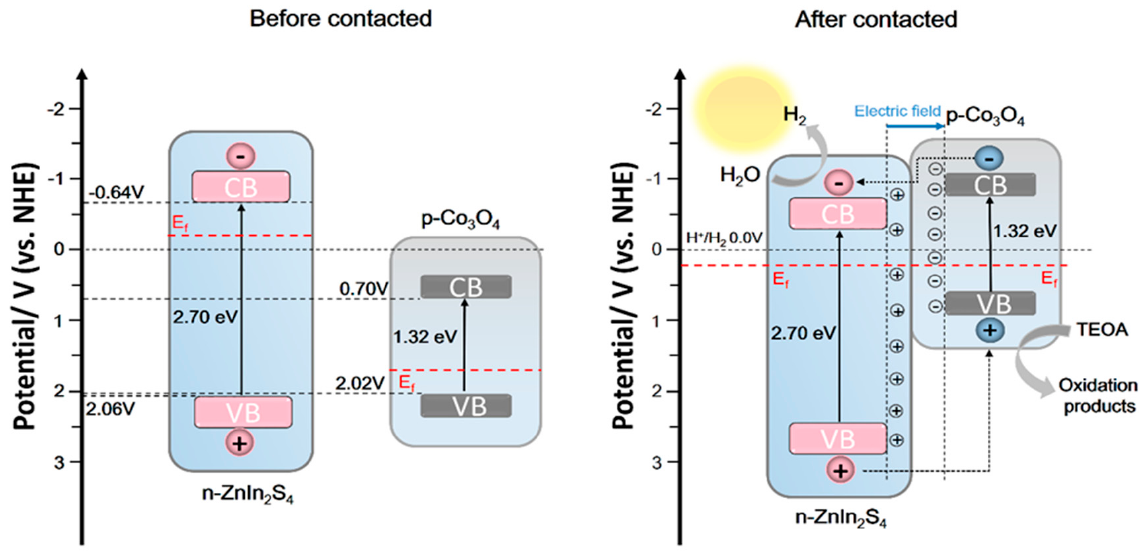
Figure 10. Mechanism of photocatalytic hydrogen production from Co 3 O 4 (X)@ZnIn 2 S 4 p-n heterojunction.